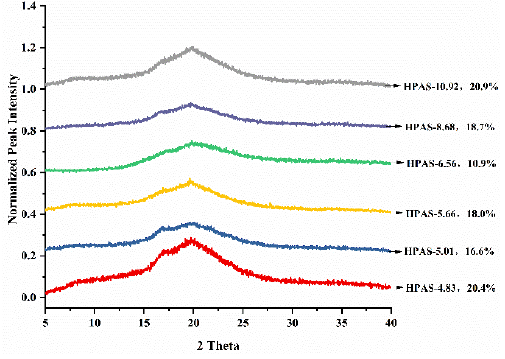
Figure 5. XRD patterns of HPAS-CA films with different citric acid amount.